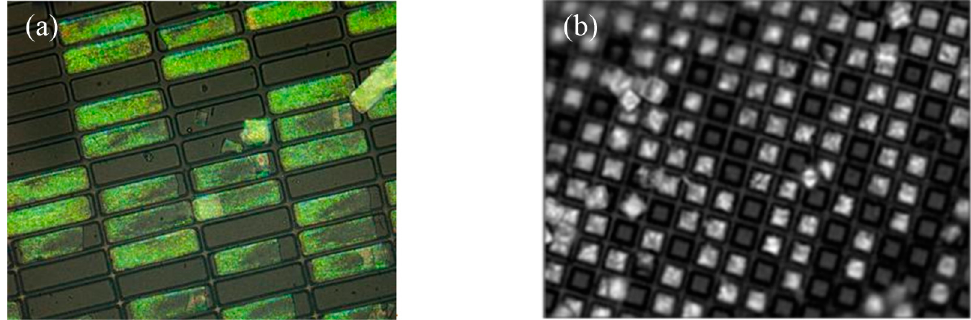
Figure 1. Flakes stick to the polydimethylsiloxane (PDMS) mold and cannot be peeled off: ( a ) Flakes fabricated by us without a polyvinyl alcohol (PVA) layer; ( b ) flakes in Trajkovska-Petkoska’s